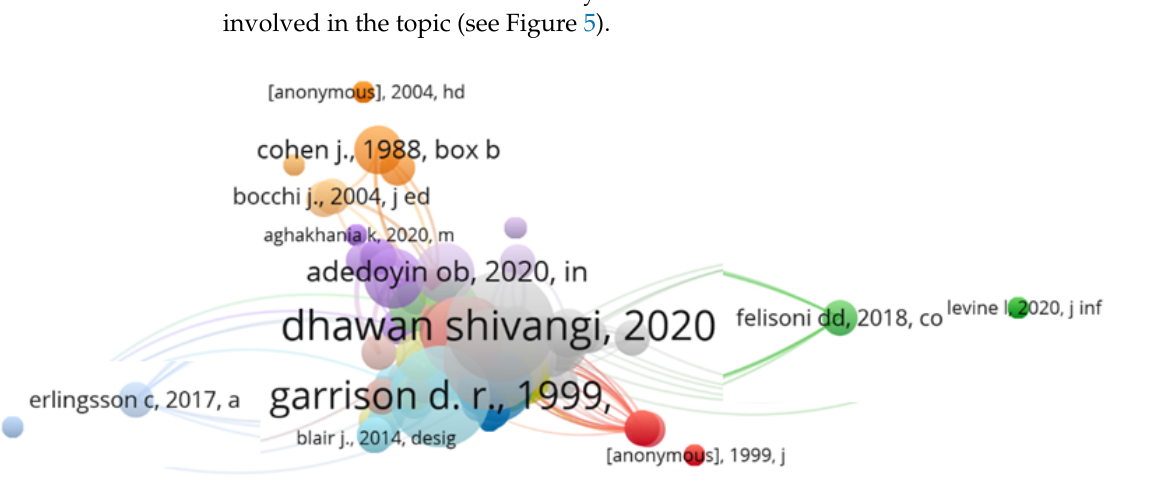
Figure 4. VOSviewer mapping of student perceptions of online education with respect to biblio- graphic coupling. Source: authors’ own analysis with VOSviewer.